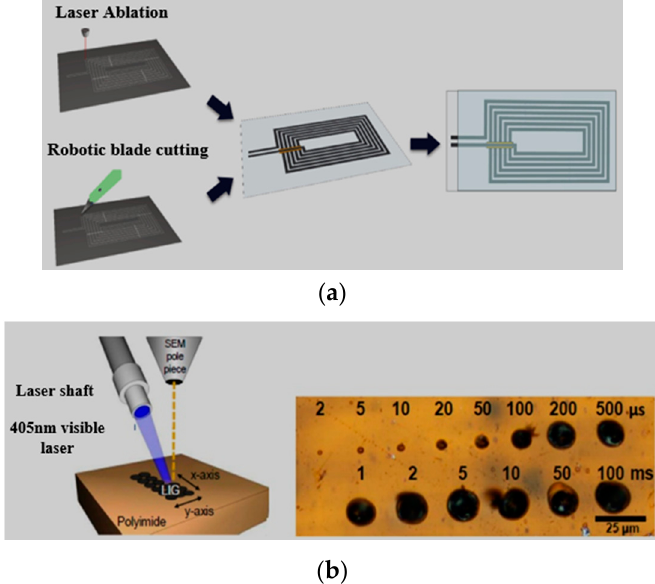
Figure 7. ( a ) Graphene antenna [174], and ( b ) infrared laser method (LIG) [227]. Table 8. Comparison of direct cutting [174,228,229].